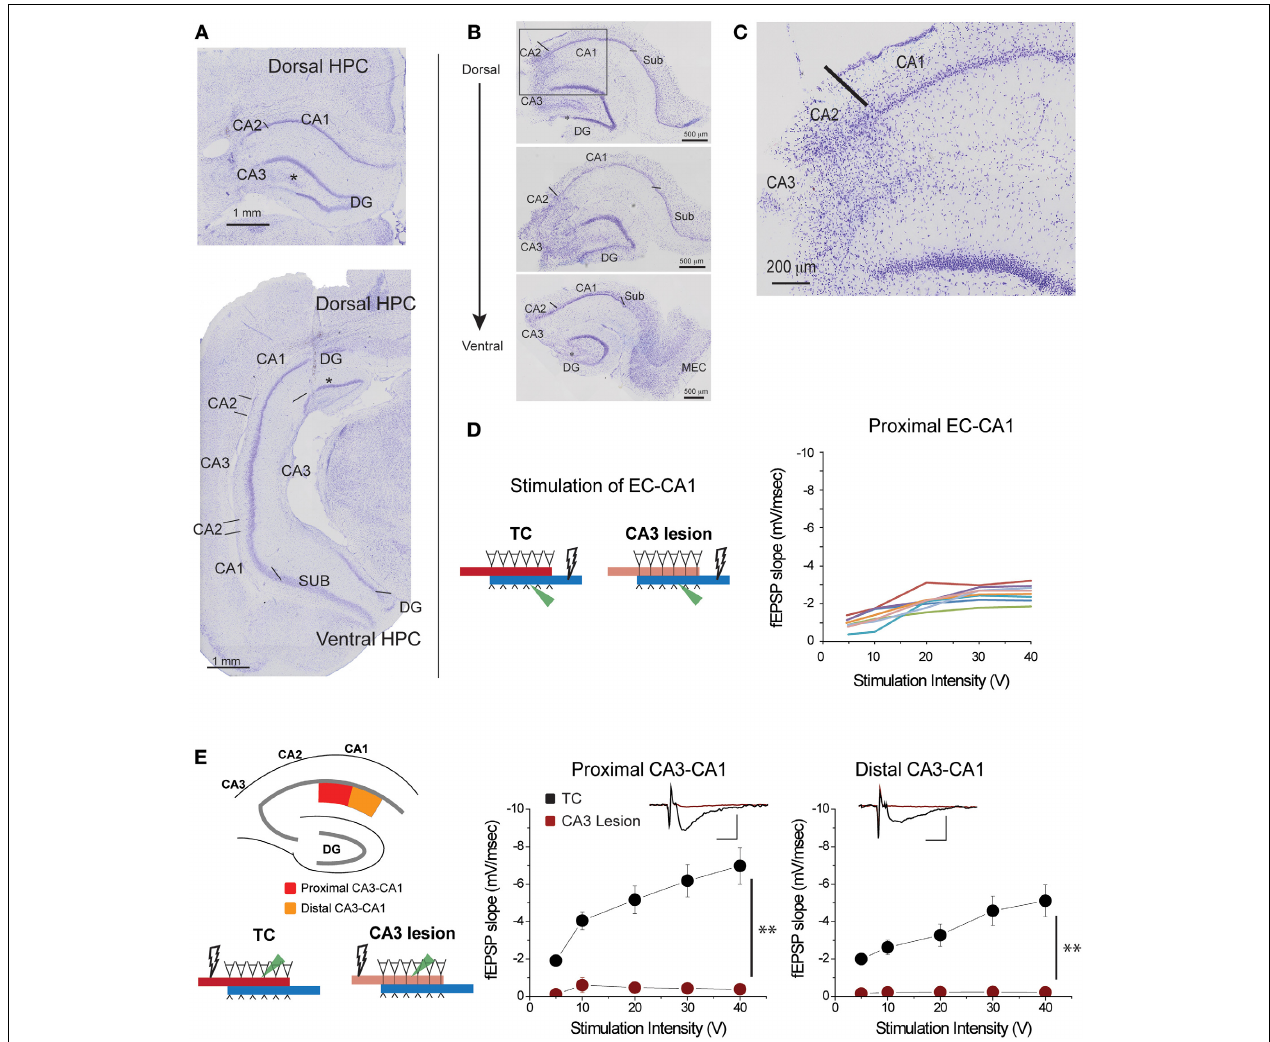
FIGURE 2 | CA3 lesions abolished CA3-CA1 transmission. (A) Coronal sections of rat brain displaying lesions in which CA3 cells were removed from both the dorsal (top) and ventral (bottom) portions of the hippocampus. CA2 was largely spared; however, a portion of the dentate gyrus (DG) outer blade was also lesioned (asterisk). (B) Representative sections from hippocampal slices obtained from a lesioned rat at the end of electrophysiological recordings. CA3 is largely lesioned along the dorsal-ventral axis, although the lower blade of DG has some damage (asterisk) as well. Lines indicate the border between CA2 and CA3, and the border between CA1 and subiculum. (C) Magnified view of the area enclosed within the gray rectangle in the top panel of (B) showing the transition between lesioned and preserved hippocampal tissue. The CA1 field was spared. (D) Responses elicited from